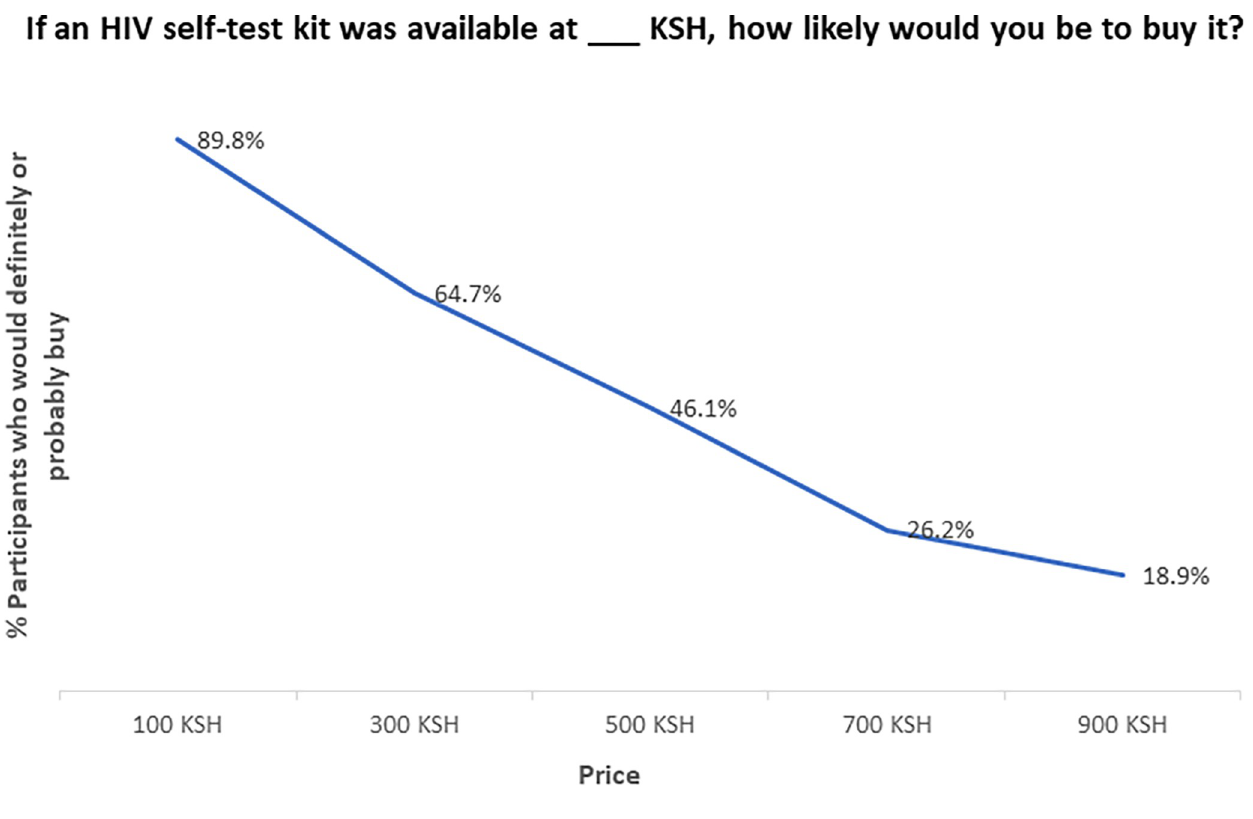
Fig 1. Willingness to pay for HIVST by price